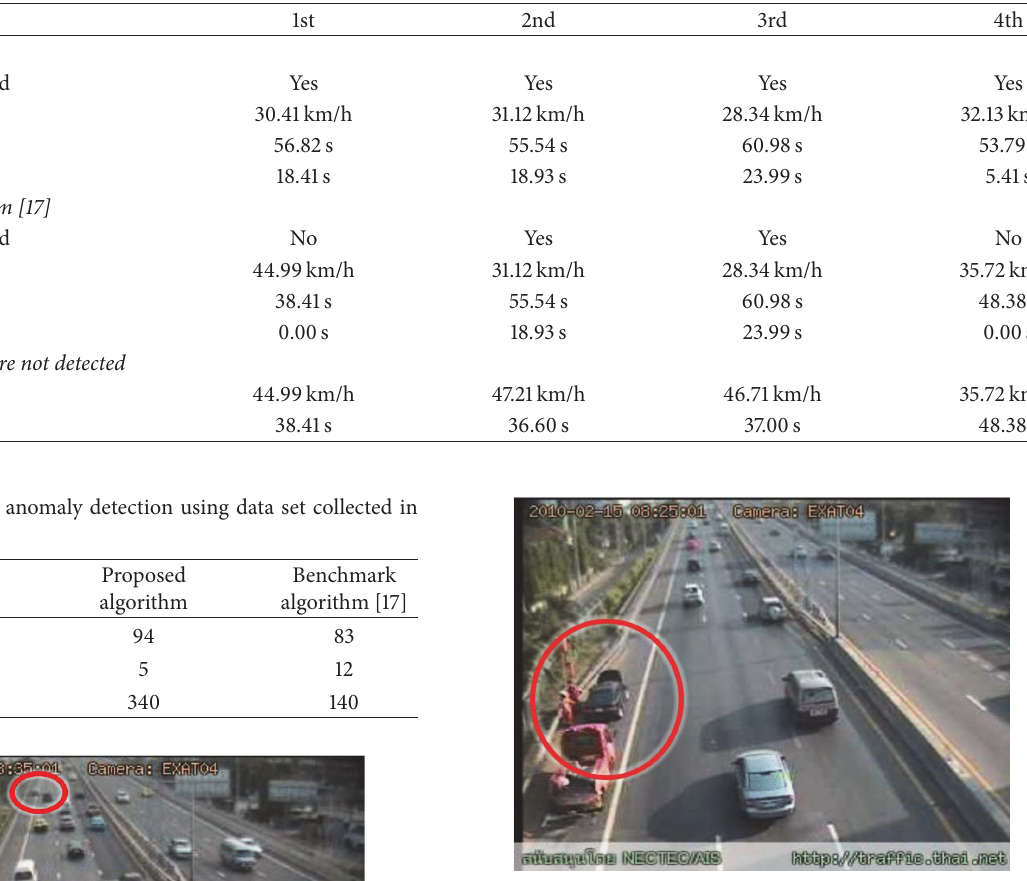
Figure 9: Another anomaly detected at the 4th camera